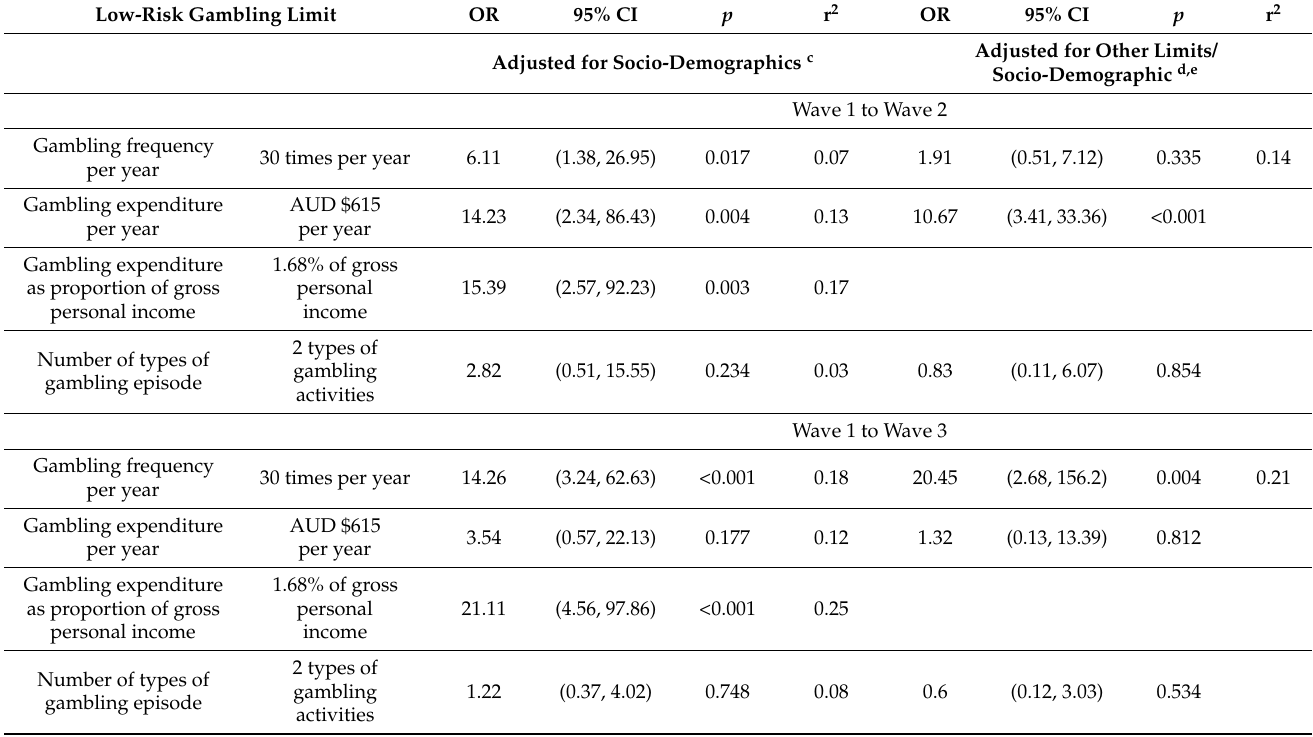
Table 3. Longitudinal prediction of gambling-related harm by the low-risk gambling limits in the Tasmanian Longitudinal Gambling Study a,b